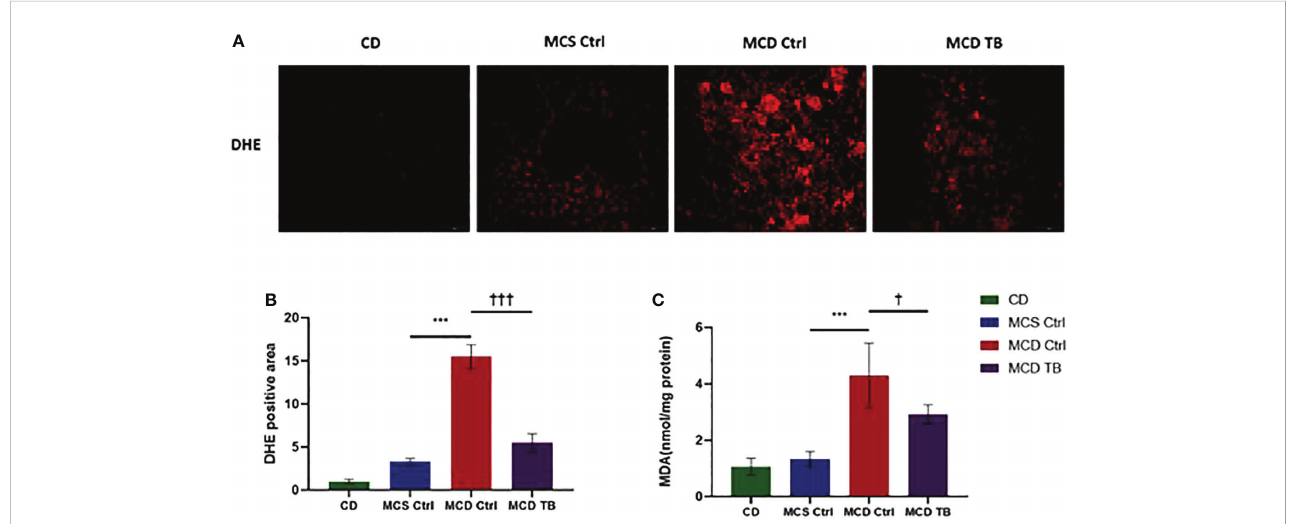
FIGURE 4 Theabrownin reduces hepatic oxidative stress in MCD diet-fed mice. (A) Liver section for ROS generation (DHE level). (B) Quanti fi cation of positive area for DHE. (C) Liver MDA level. n=5-11 mice per group. The data are mean ± s.e. (error bars). ***p < 0.001, MCS Ctrl vs. MCD Ctrl. † , p<0.05, ††† , p<0.001 MCD Ctrl vs. MCD